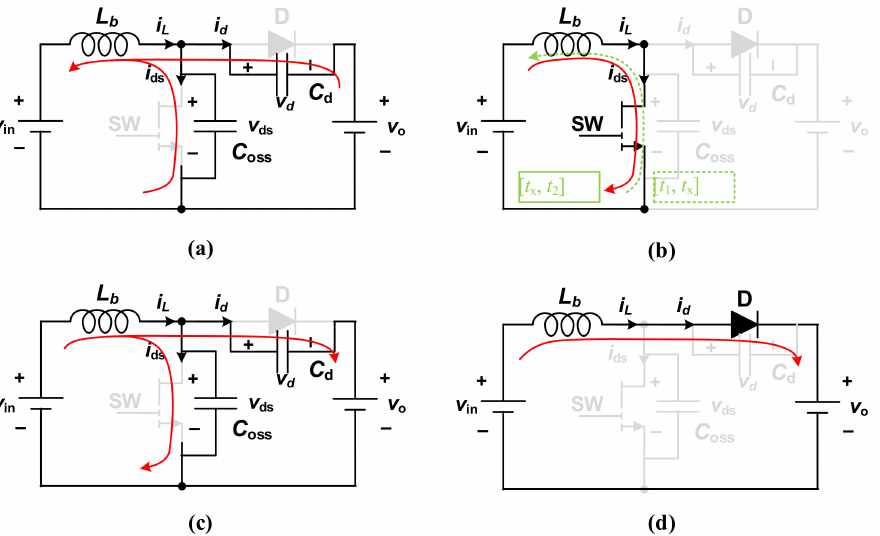
Figure 3. Operating circuits: ( a ) the reverse resonant period, i.e., [ t 0 , t 1 ]; ( b ) the switching-on period, i.e., [ t 1 , t 2 ]; ( c ) the forward resonant period, i.e., [ t 2 , t 3 ]; ( d ) the diode conduction period, i.e., [ t 3 , t 4